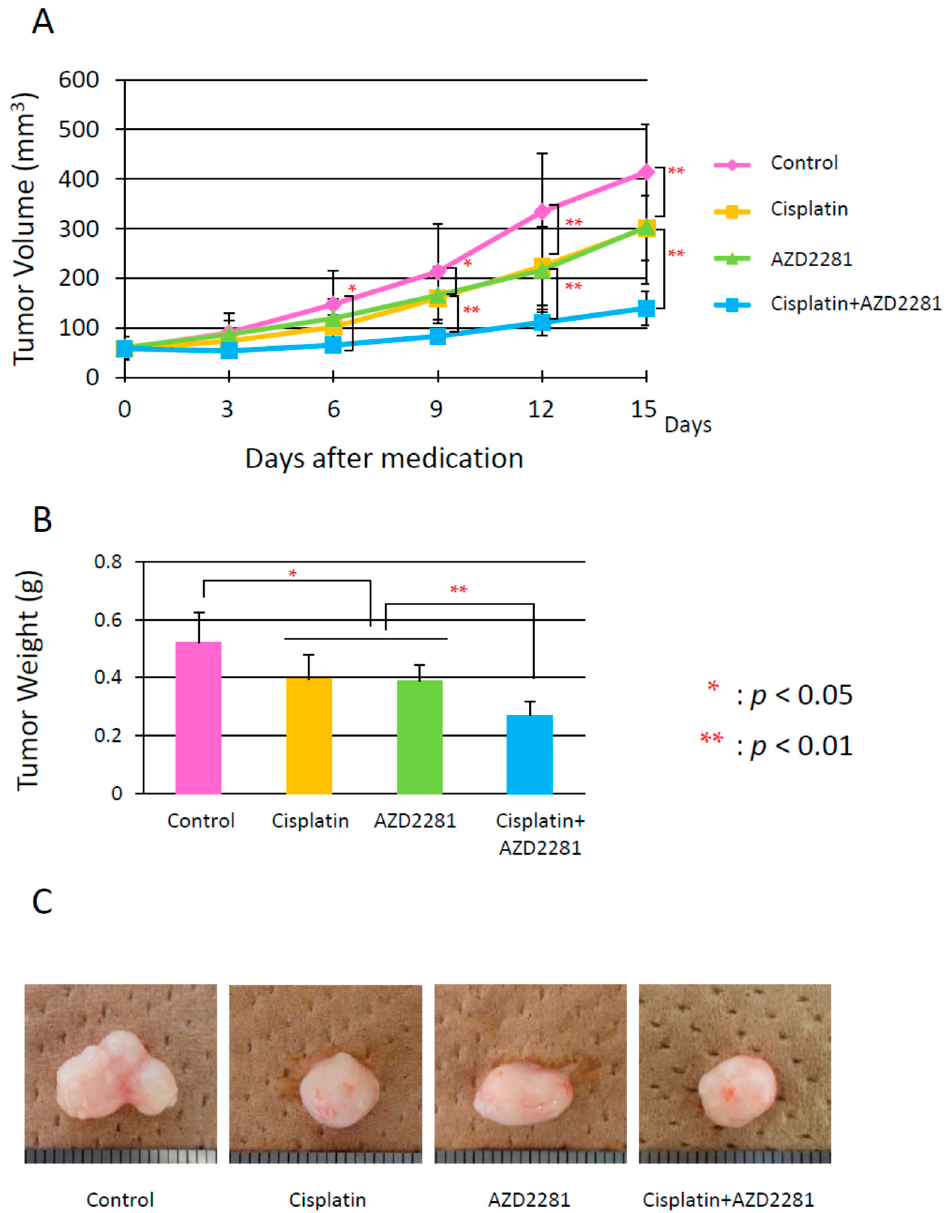
Figure 3. ( A ) Increases in tumor volumes during treatment with cisplatin or AZD2281, or combinatorial treatment with both cisplatin and AZD2281; ( B ) tumor weights just after sacrifice in the control, cisplatin, AZD2281, and combination groups; and ( C ) photos of representative tumors in the control, cisplatin, AZD2281, and combination treatment groups. Values are expressed as the mean ± SEM. * p < 0.05; ** p < 0.01.